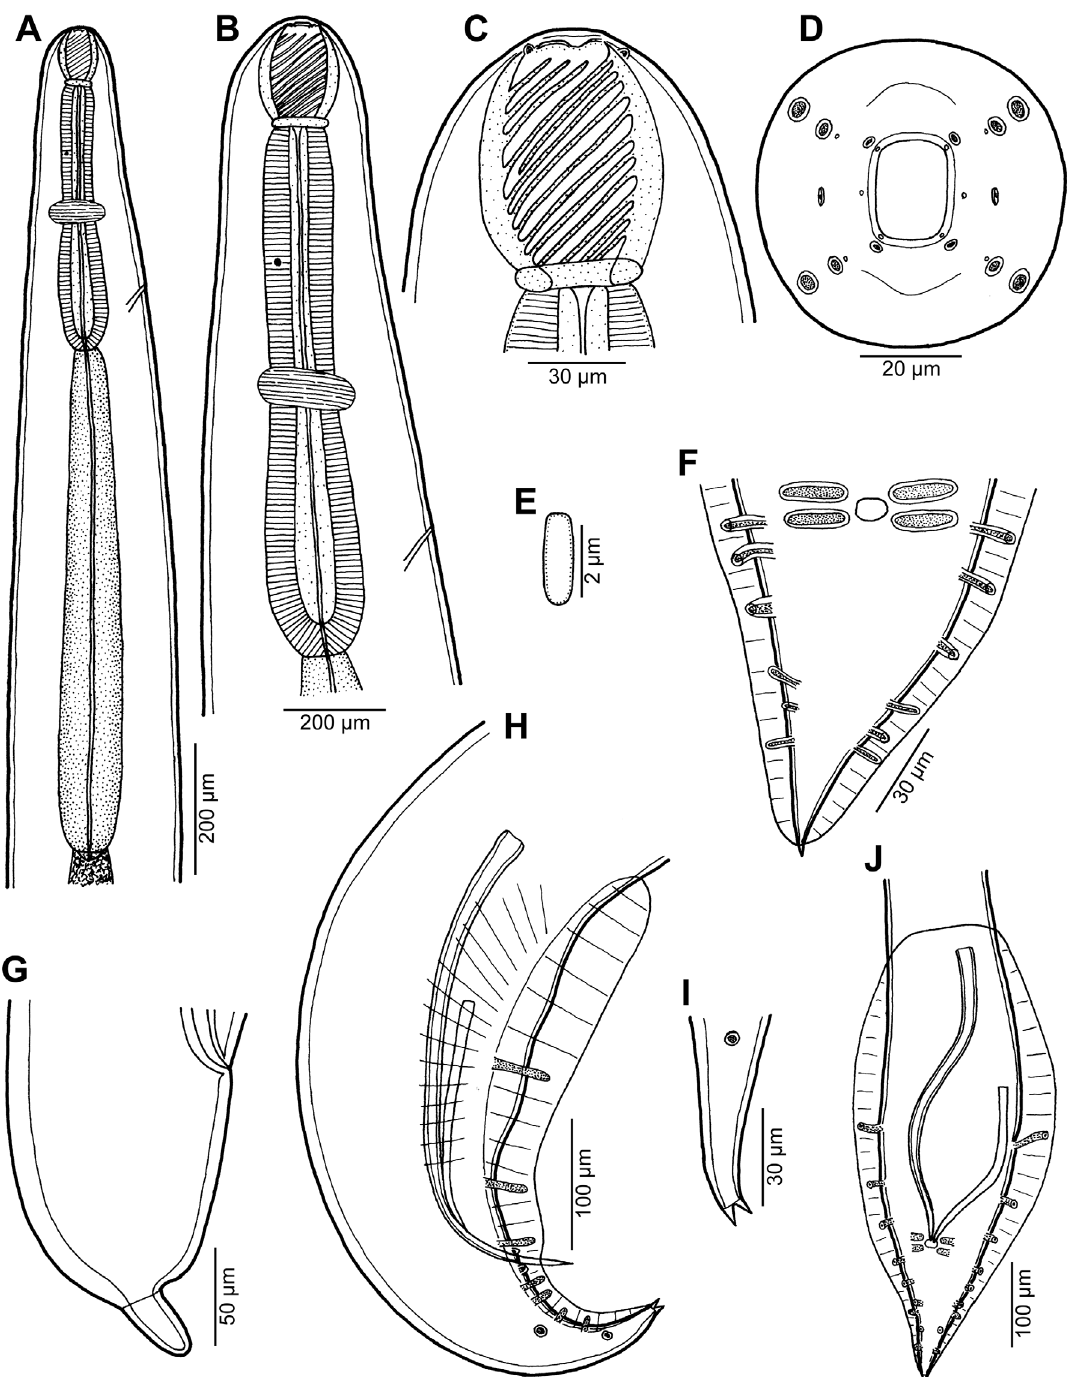
Figure 1. Procamallanus ( Spirocamallanus ) dispar n. sp. from Leiognathus equulus . (A) Anterior end of male, lateral view; (B) same, enlarged; (C, D) cephalic end of male, lateral and apical views, respectively; (E) deirid; (F) tail of male, ventral view; (G) tail of subgravid female, lateral view; (H) posterior end of male, lateral view; (I) tail tip of juvenile male, lateral view; (J) posterior end of juvenile male, ventral